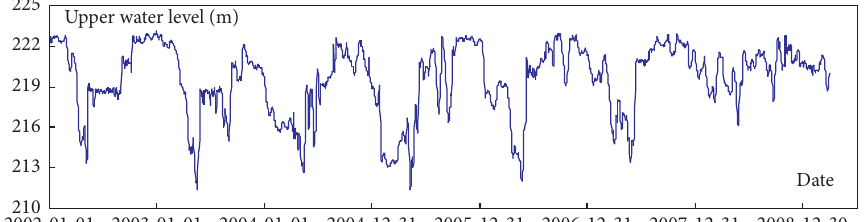
Figure 3: Variation curve of the measured upper water level of the dam.